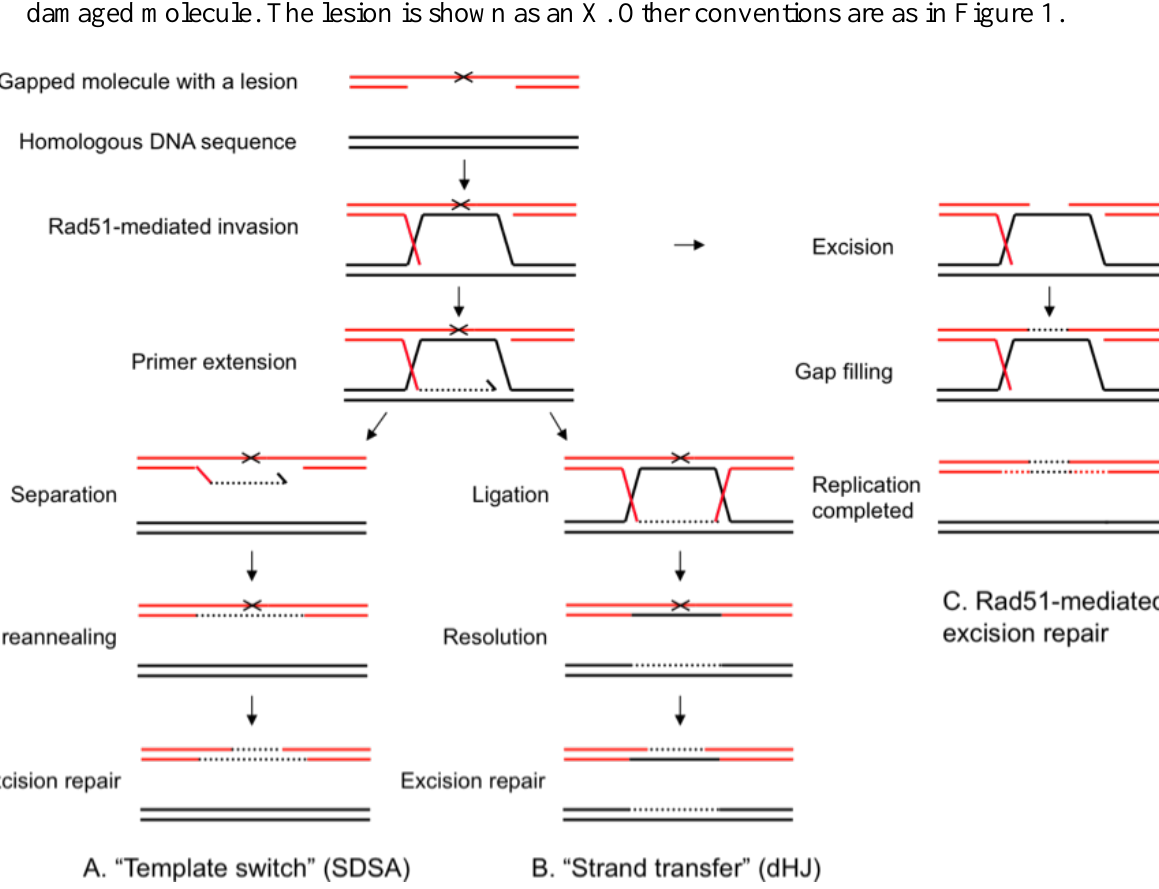
Figure 4. Recombinational mechanisms of gap-repair. A single-strand gap opposite a non-replicating lesion can be repaired by recombination using a homologous DNA molecule. The polymerase filling the gap can switch to the donor template (black), while the displaced donor strand anneals in the gap on the recipient molecule, so that a D-loop is formed in a reaction similar to Rad51-mediated DSB repair (Figure 1). ( A ), in template- switching gap repair, the newly synthesized strand is separated from its template, as in SDSA, and then re-anneals with the damaged strand. This allows removal of the lesion by excision repair; ( B ), the double Holliday junction formed by the switch is resolved by endonuclease or by helicase with topoisomerase as in dHJ recombination, again allowing excision repair; ( C ), Rad51-mediated excision repair uses a Rad51-mediated invasion to form a D-loop. The displaced strand of the D-loop anneals with the region containing the lesion, and provides a template for excision repair. In all three cases, sequence from the donor molecule (black) has been transferred to the damaged molecule (red) so that any allelic differences would have been transferred by conversion from the donor to the damaged molecule. The lesion is shown as an X. Other conventions are as in Figure